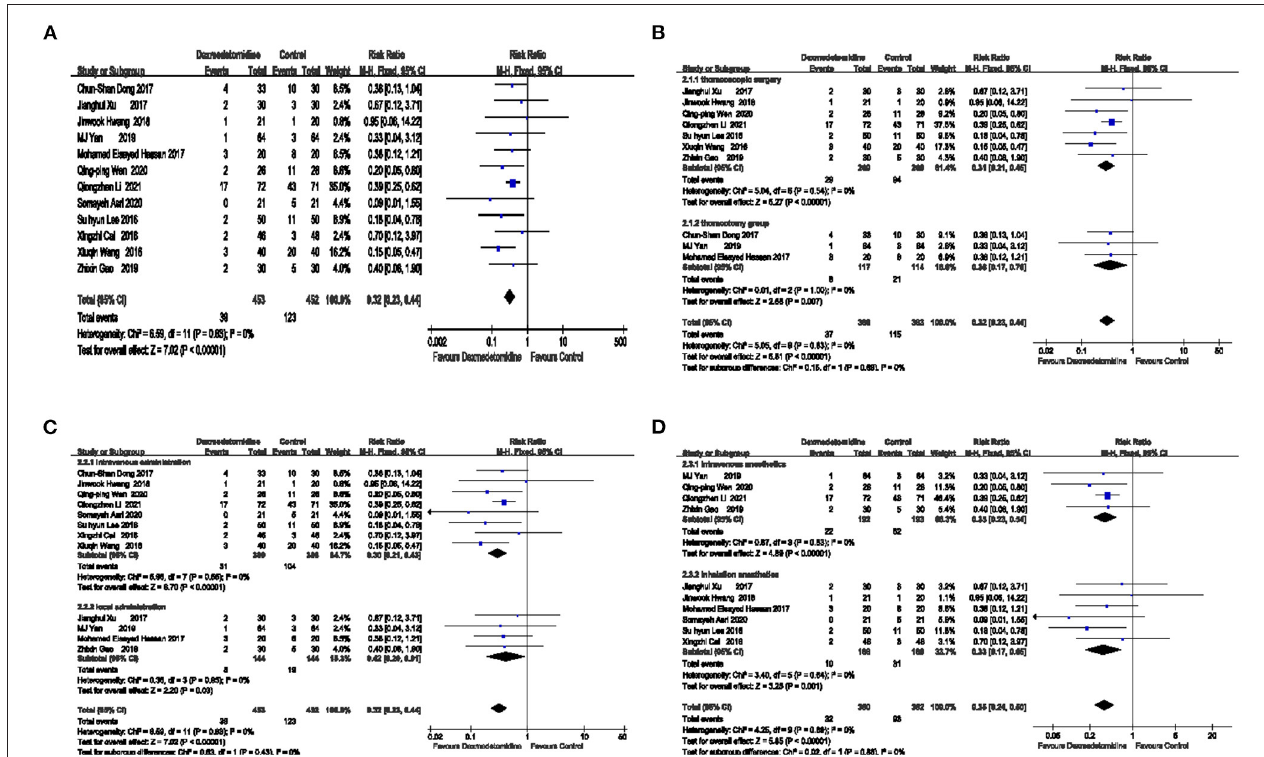
FIGURE 3 | The effect of dexmedetomidine on the incidence of postoperative nausea and vomiting (PONV). The risk of PONV was lower in the dexmedetomidine group compared with the control group (A) . Dexmedetomidine reduced the occurrence of PONV in both thoracoscopic surgery and thoracotomy (B) . Dexmedetomidine reduced the occurrence of PONV regardless of whether it was intravenously or locally administered (C) . Dexmedetomidine reduced the occurrence of PONV regardless of whether it was combined with intravenous anesthetics or inhalation anesthetics (D)